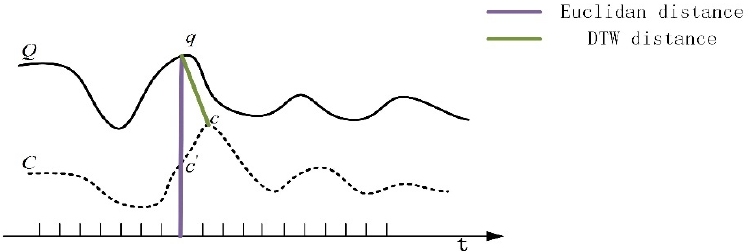
Figure 5. Example of the difference between Euclidean distance and DTW distance. (cid:0) (cid:1) q i , c j The sum of the Euclidean distance d between grid locations q i and c j is separated into two-time series. The cumulative distance of the smallest neighbouring element